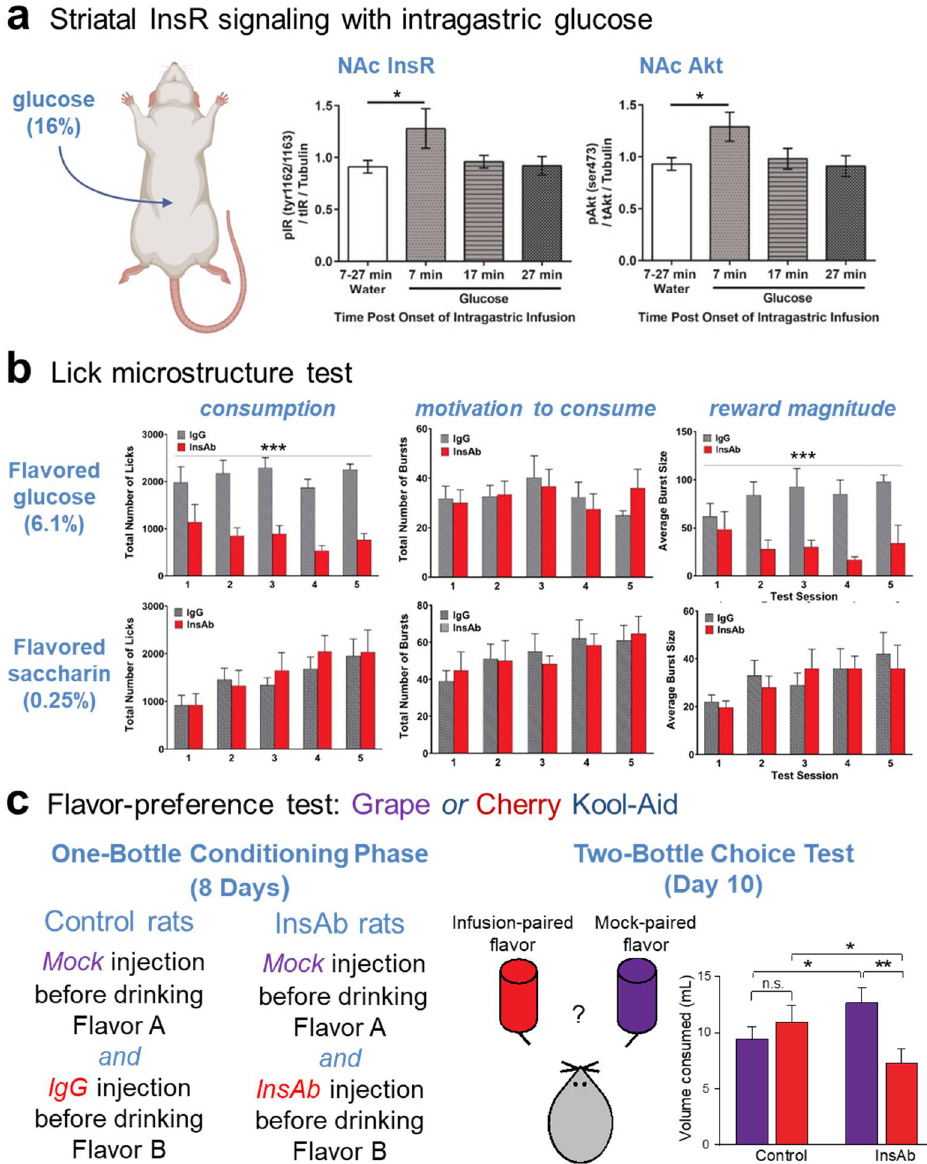
Figure 4. Endogenous activation InsRs in NAc shell is required for sensing nutrient value. ( a ) Phosphorylation of insulin receptors (InRs) and Akt in rat nucleus accumbens (NAc) are increased within seven minutes of intragastric glucose (16%) infusion; modified from [102]. ( b ) Lick microstructure analysis during NAc shell insulin antibody (InsAb) microinjection decreases consumption of flavored 6.1% glucose but not of non-nutritive flavored saccharin through a decrease in reward magnitude; modified from [103]. ( c ) In a two-bottle flavor preference test, InsAb rats drink less of an infusion-paired flavor vs. a mock-paired flavor than controls; modified from [19]. In ( a – c ), n.s. is not significant, * p < 0.05, ** p < 0.01, *** p < 0.001.